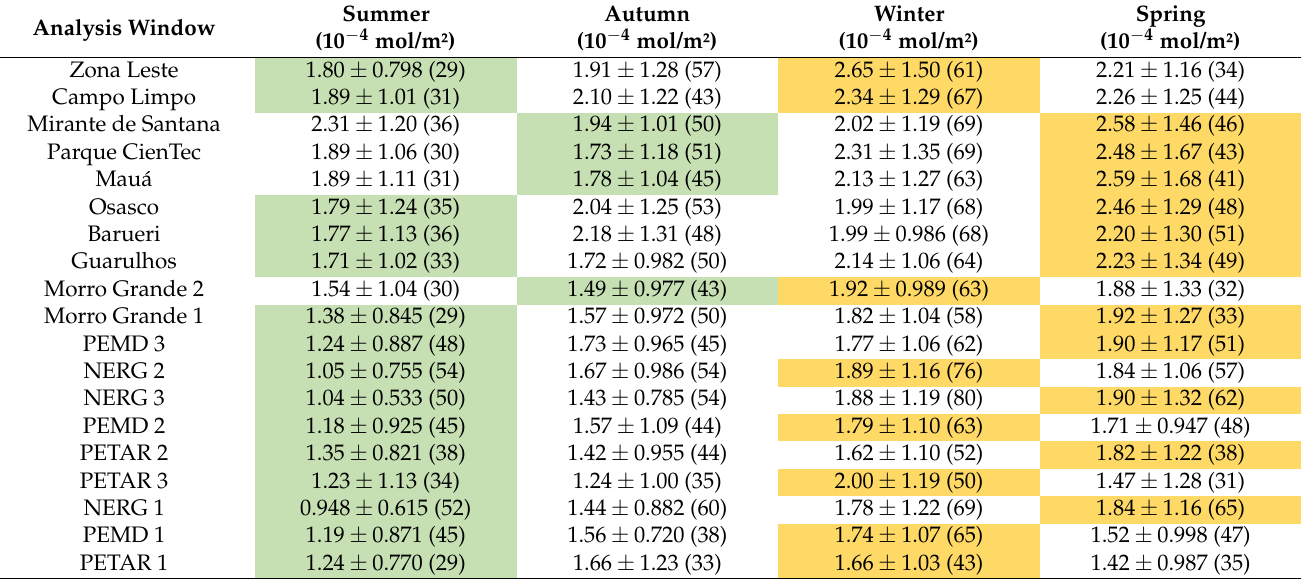
Table 2. Mean of the HCHO columns (12 p.m.–4 p.m. local time) for each season of 2020. The number of days with data is shown in parentheses, and the maximum (yellow) and minimum (green) mean values are highlighted for each analysis